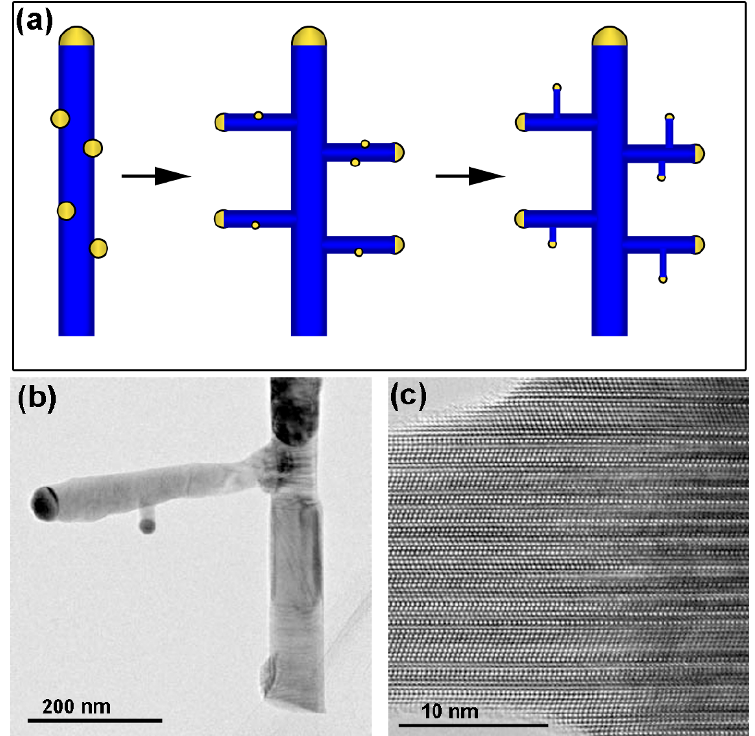
Figure 1. Branched nanowires synthesized through sequential seeding following the VLS growth processes. (a) A schematic illustration of the process. (b) Transmission electron micrograph showing the main trunk (vertical) and two generations of branches. (c) High resolution imaging reveals the single-crystalline nature of the junctions that connect the trunk and branch nanowires (reproduced with permission from Nature Publishing Group